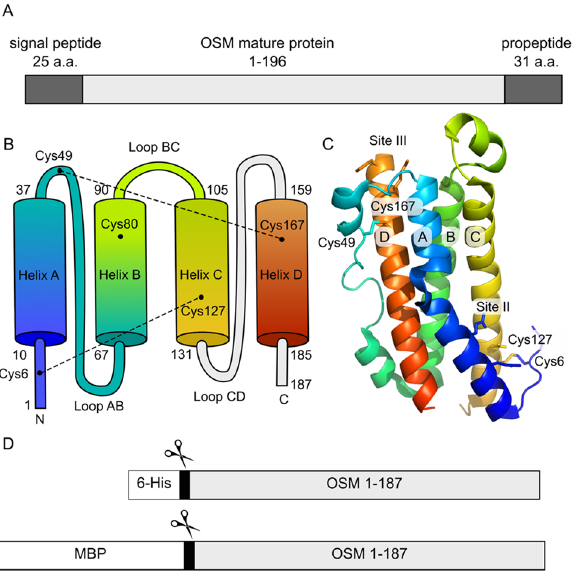
Figure 1. OSM structure overview. ( A ) Schematic representation of the OSM gene product. Signal peptide and propeptide are removed post-translationally. ( B ) Domain architecture of OSM showing the four helices A, B, C and D and disulfide bonds. The Loop CD and the C-terminus were not observed in the crystal structure 28 and are colored gray. ( C ) Cartoon representation of OSM from PDBID 1EVS, Site II, Site III, and disulfides are shown as sticks, colored according to domain architecture. ( D ) Schematic representation of the